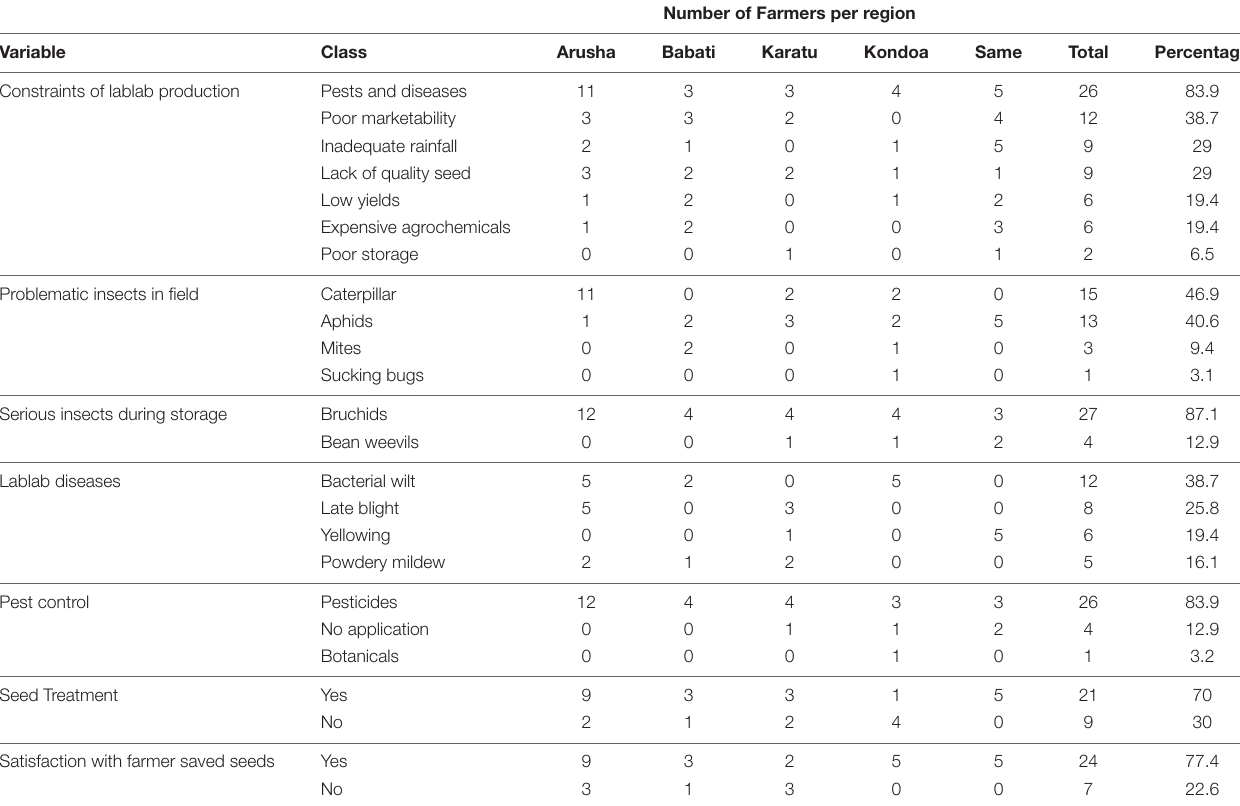
TABLE 3 | Major constraints in lablab production.